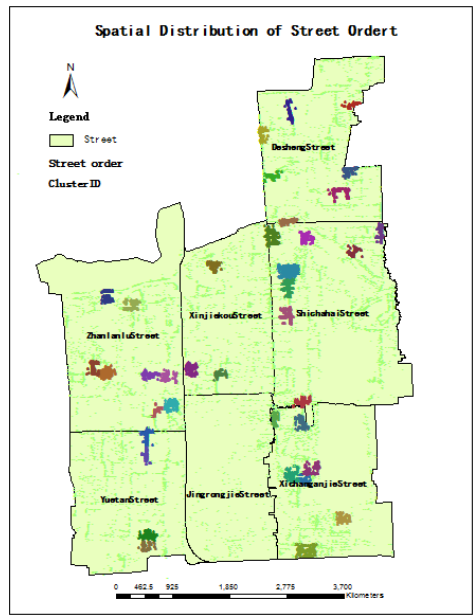
not constitute a distinct cluster.